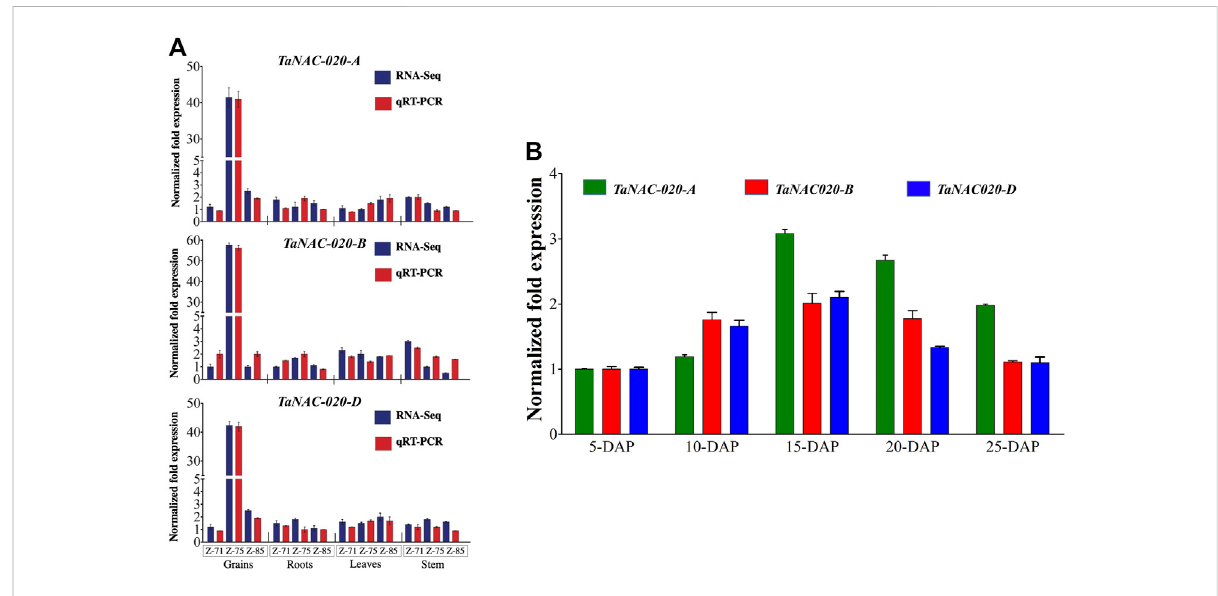
FIGURE 2 Gene expression pattern. (A) Tissue and stage-speci fi c expression pro fi le of candidate genes (Wheat-Exp database and qRT-PCR). (B) Normalized fold expression of TaNAC020- A/B/D at different stages of the day after pollination (DAP). Error bar denotes